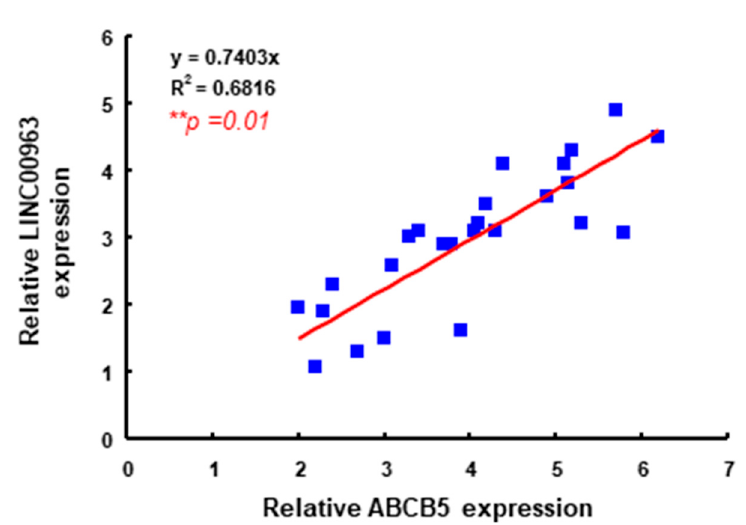
Figure 8. A positive correlation between LINC00963 expression and ABCB5 in Taiwanese OSCC specimens by qRT-PCR and linear regression analysis. ** p < 0.01.